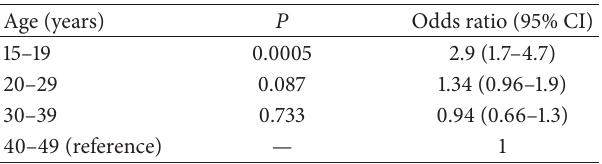
Table 4: Logistic regression analysis of age groups on the likelihood of the presence of rubella